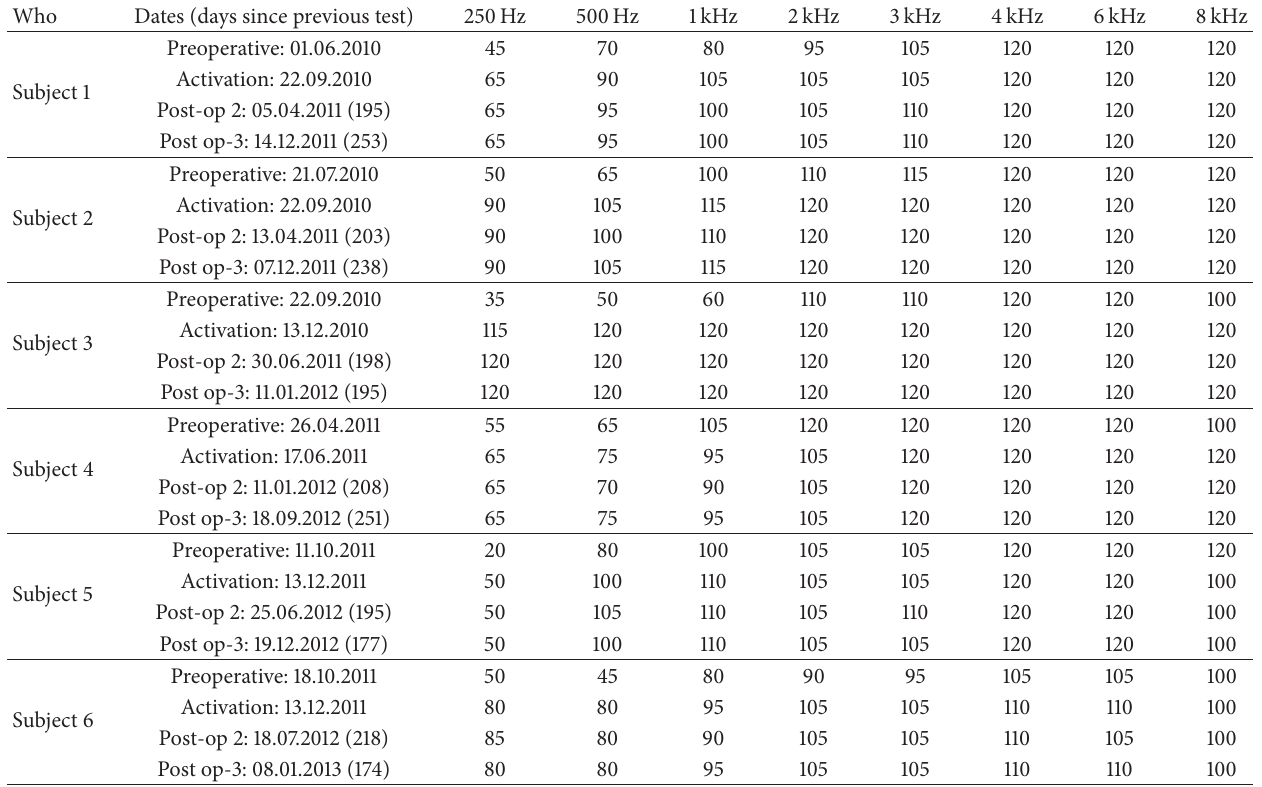
Table 2: PTA tests of all subjects at all intervals: